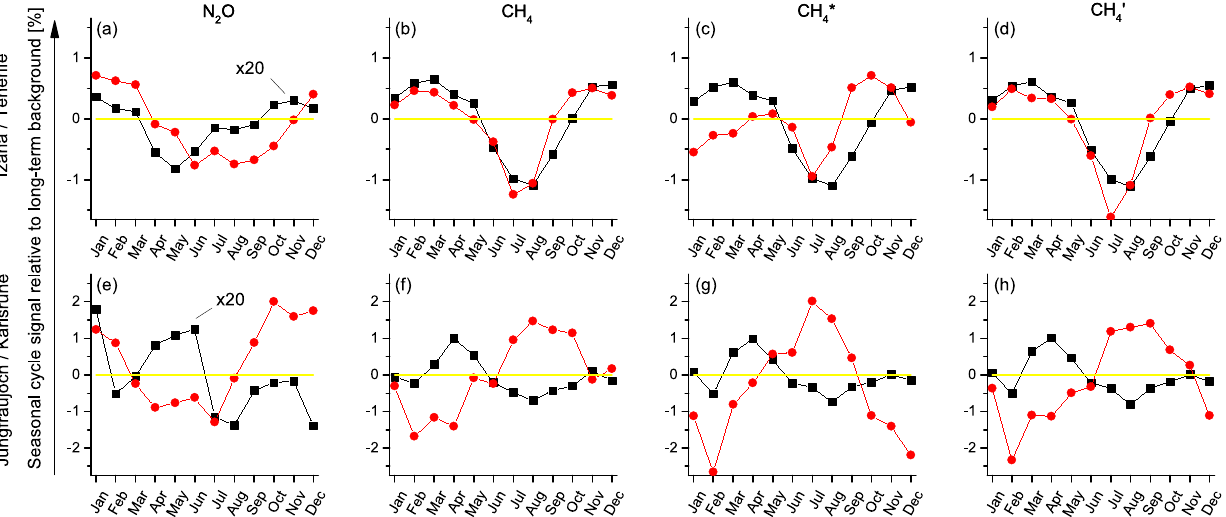
Figure 13. Seasonal cycle as obtained from the daily night mean MUSICA IASI products (4.2km retrieval, red) and coinciding GAW high-mountain observatory in situ data (black): (a–d) for the surroundings of Tenerife Island; (e–h) for the surroundings of Karlsruhe; (a) and (e) for N 2 O; (b) and (f) for CH 4 ; (c) and (g) for CH ∗ in Table 2. The yellow line indicates the a priori data (fixed a priori value, i.e. no seasonal cycle signal). The N 2 O GAW signals ( a and e ) are multiplied by a factor of